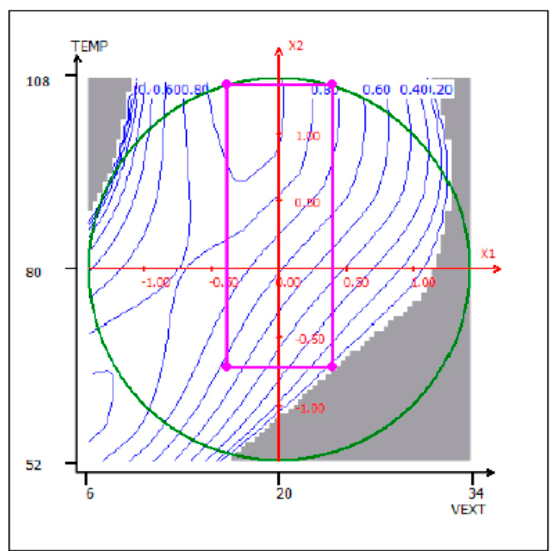
Figure 3. Contour plot of the global desirability function and the design space given by the operating parameter ranges satisfying the constraints of Equation (2).